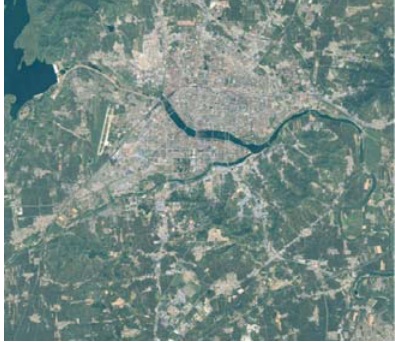
Figure 7. The thumbnail